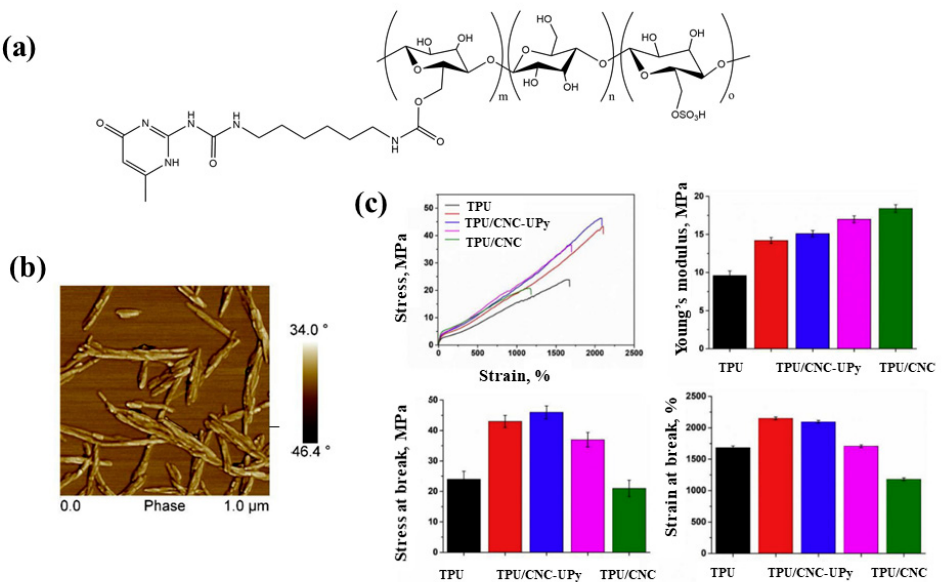
Figure 7. Structure of modi fi ed nanocellulose (CNC ‒ UPy) by in situ polymerization ( a ), AFM im- ages CNC ‒ UPy ( b ), mechanical properties of native TPU and composites in the presence of modi- TPU/CNC − UPy and unmodified TPU/CNC nanocellulose ( c ). Adapted from fi ed TPU/CNC − UPy and unmodi fi ed TPU/CNC nanocellulose ( c ). Adapted from [141].